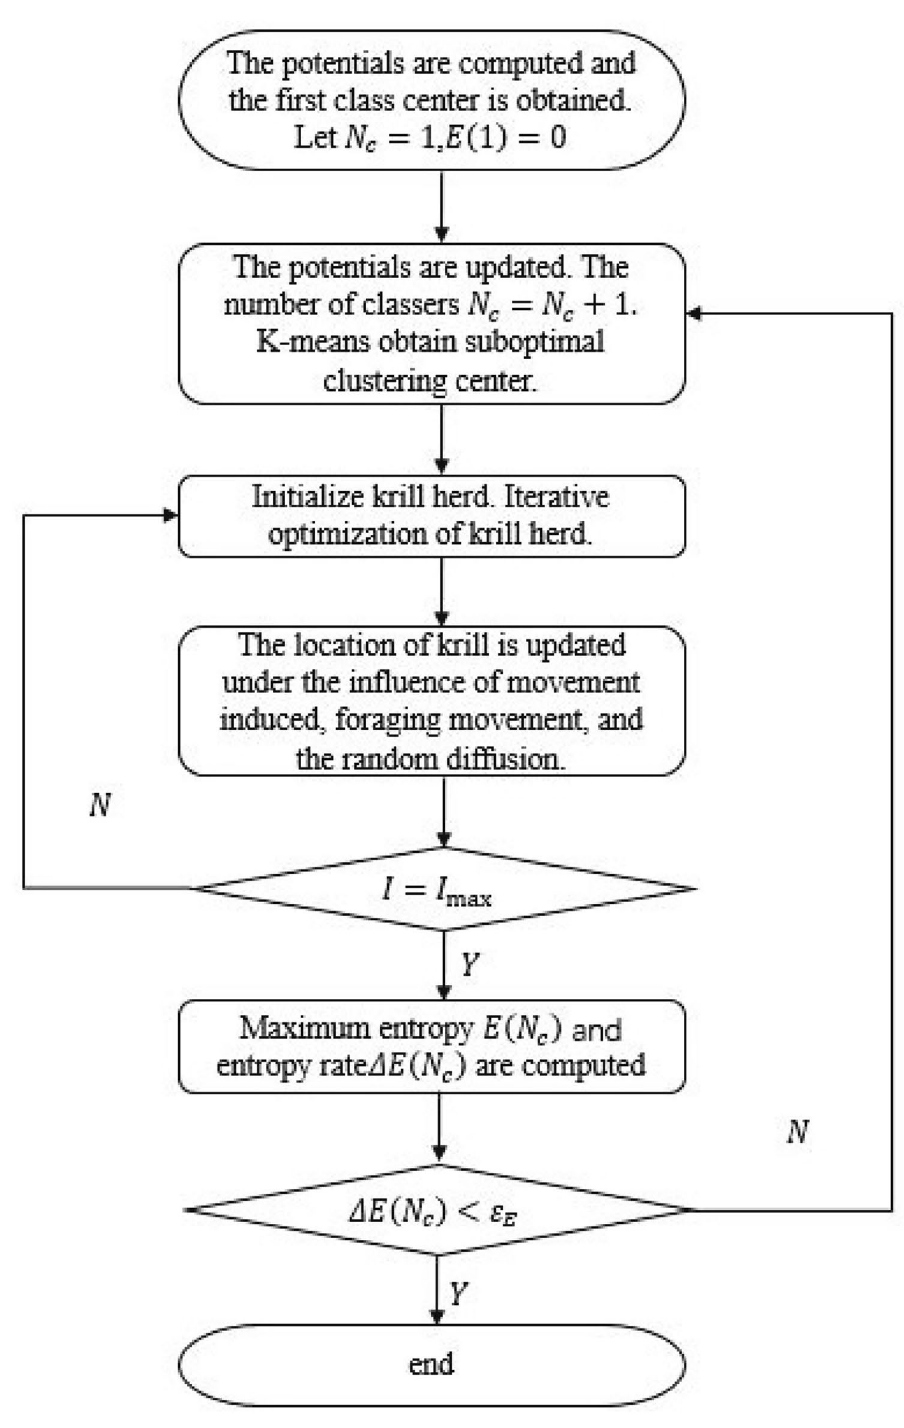
Fig. 1 The flow of maximum entropy clustering